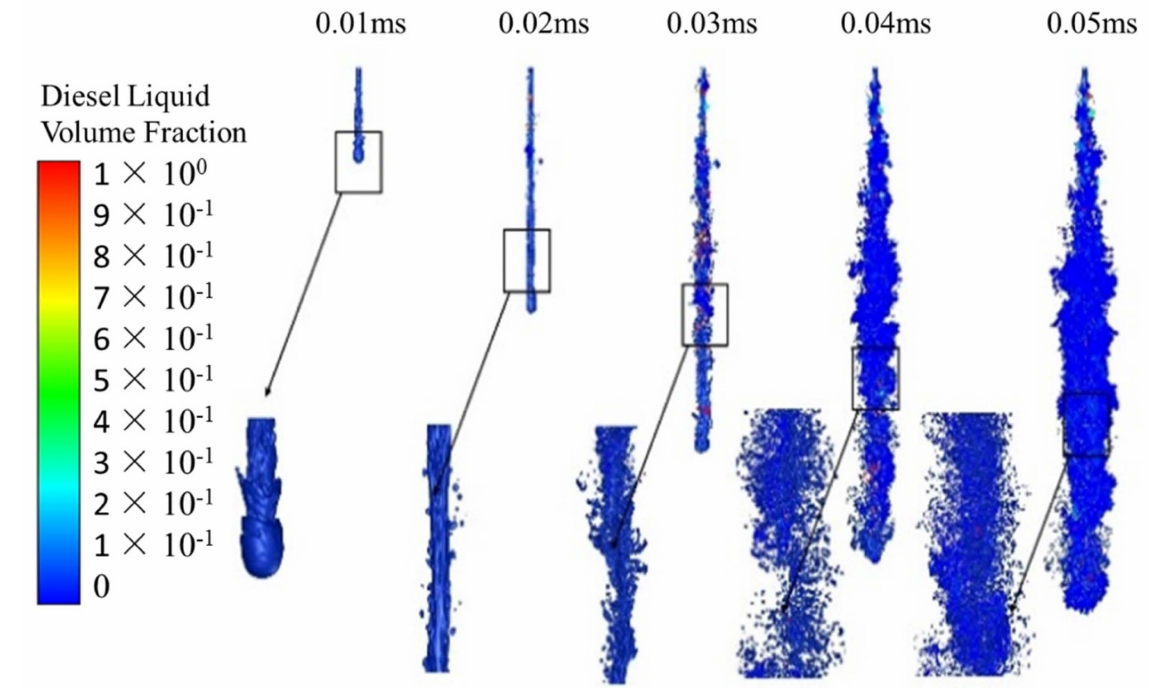
Figure 9. Primary breakup of SD-ELSA model. ( p injection = 100 MPa, p b = 1